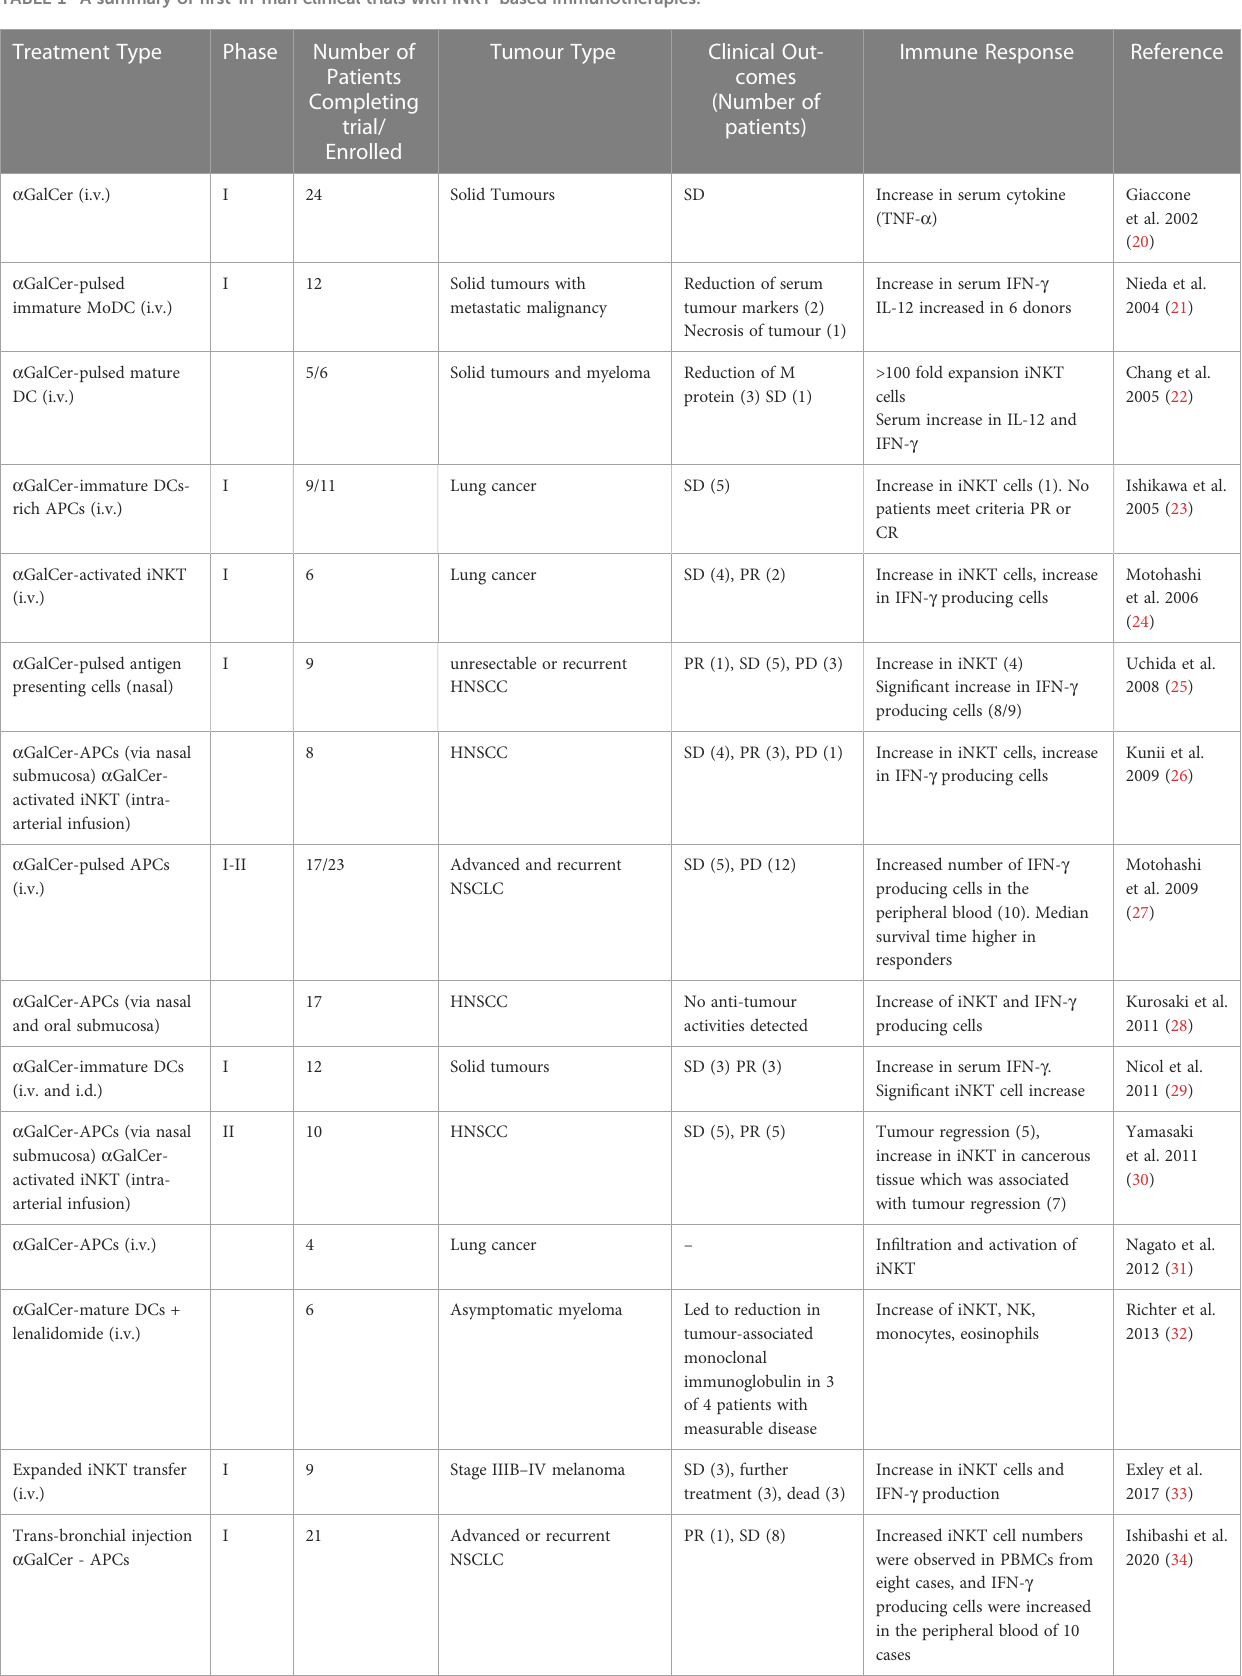
TABLE 1 A summary of fi rst-in-man clinical trials with iNKT-based